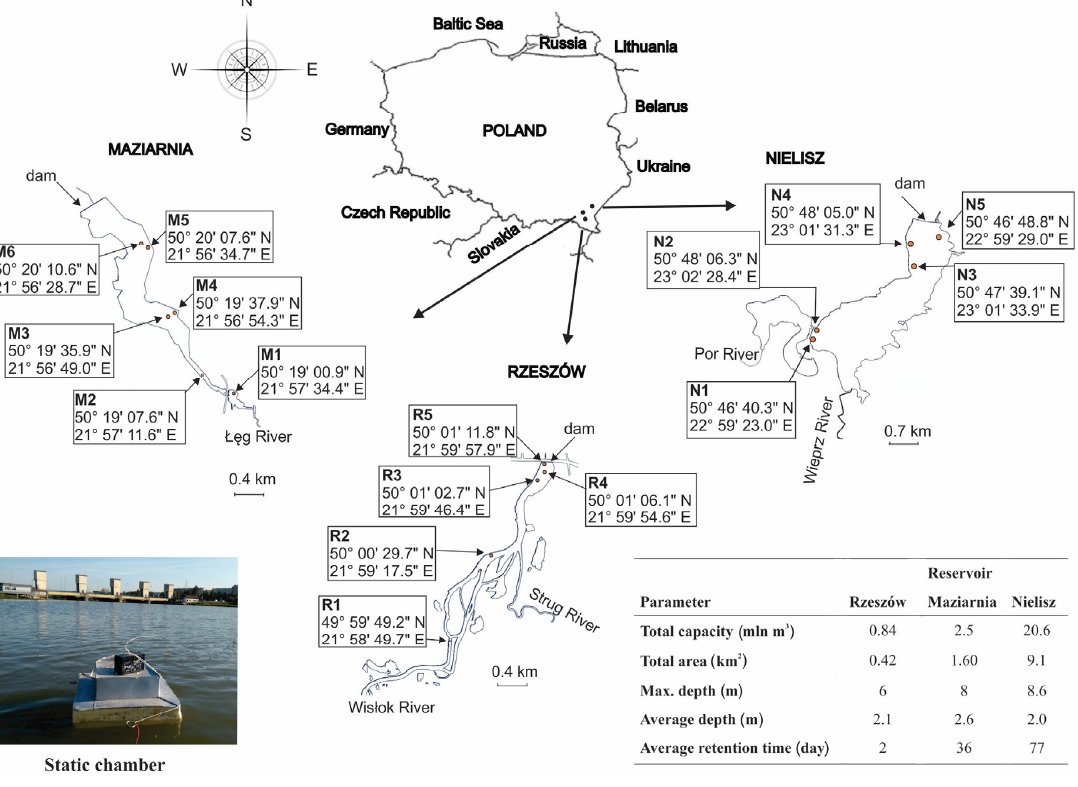
Figure 2. Locations of the reservoirs studied and their measuring stations.